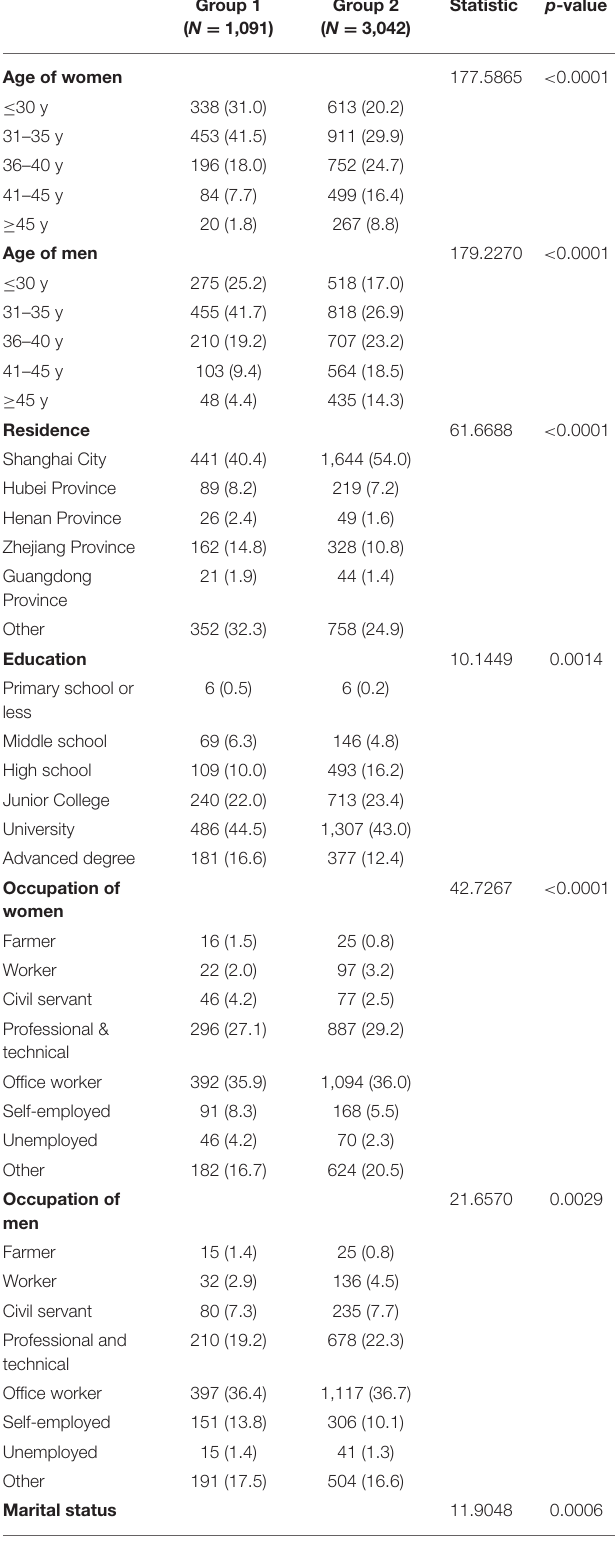
TABLE 1 | Basic information of 4,133